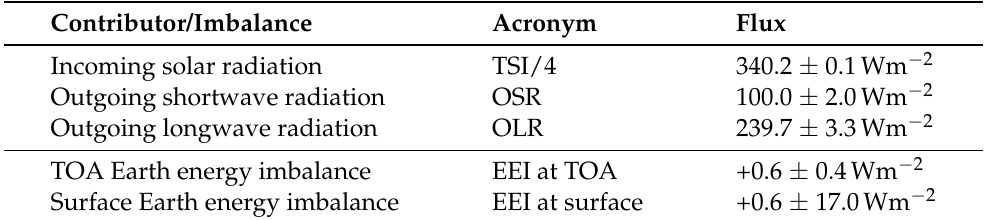
Figure 5. Radiation budget diagram of the Earth’s atmosphere from Stephens et al. (2012) [12]. ERB for the period 2000–2010, where all flows are expressed in Wm − 2 . Table 1. ERB main contributions and EEI during the period 2000–2010 from Stephens et al. (2012)